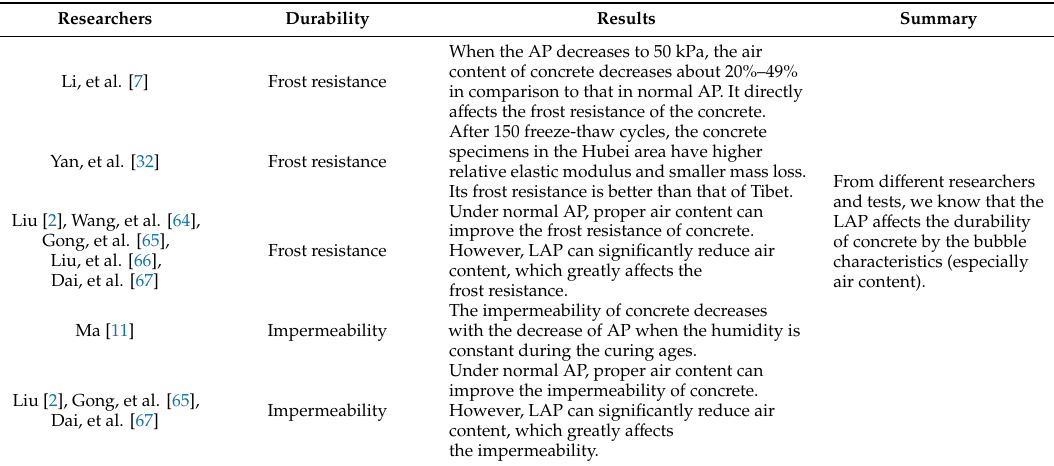
Table 11. Influence of normal AP / LAP on the durability of